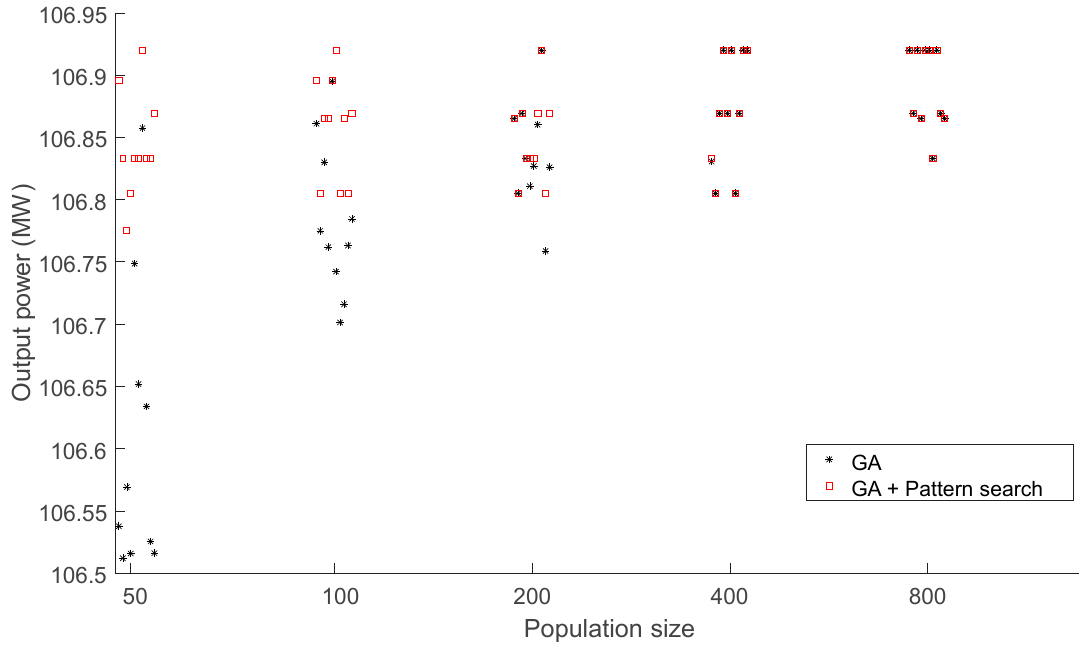
Figure 14. Repeatability analysis of the optimisation algorithm depending on the population size.